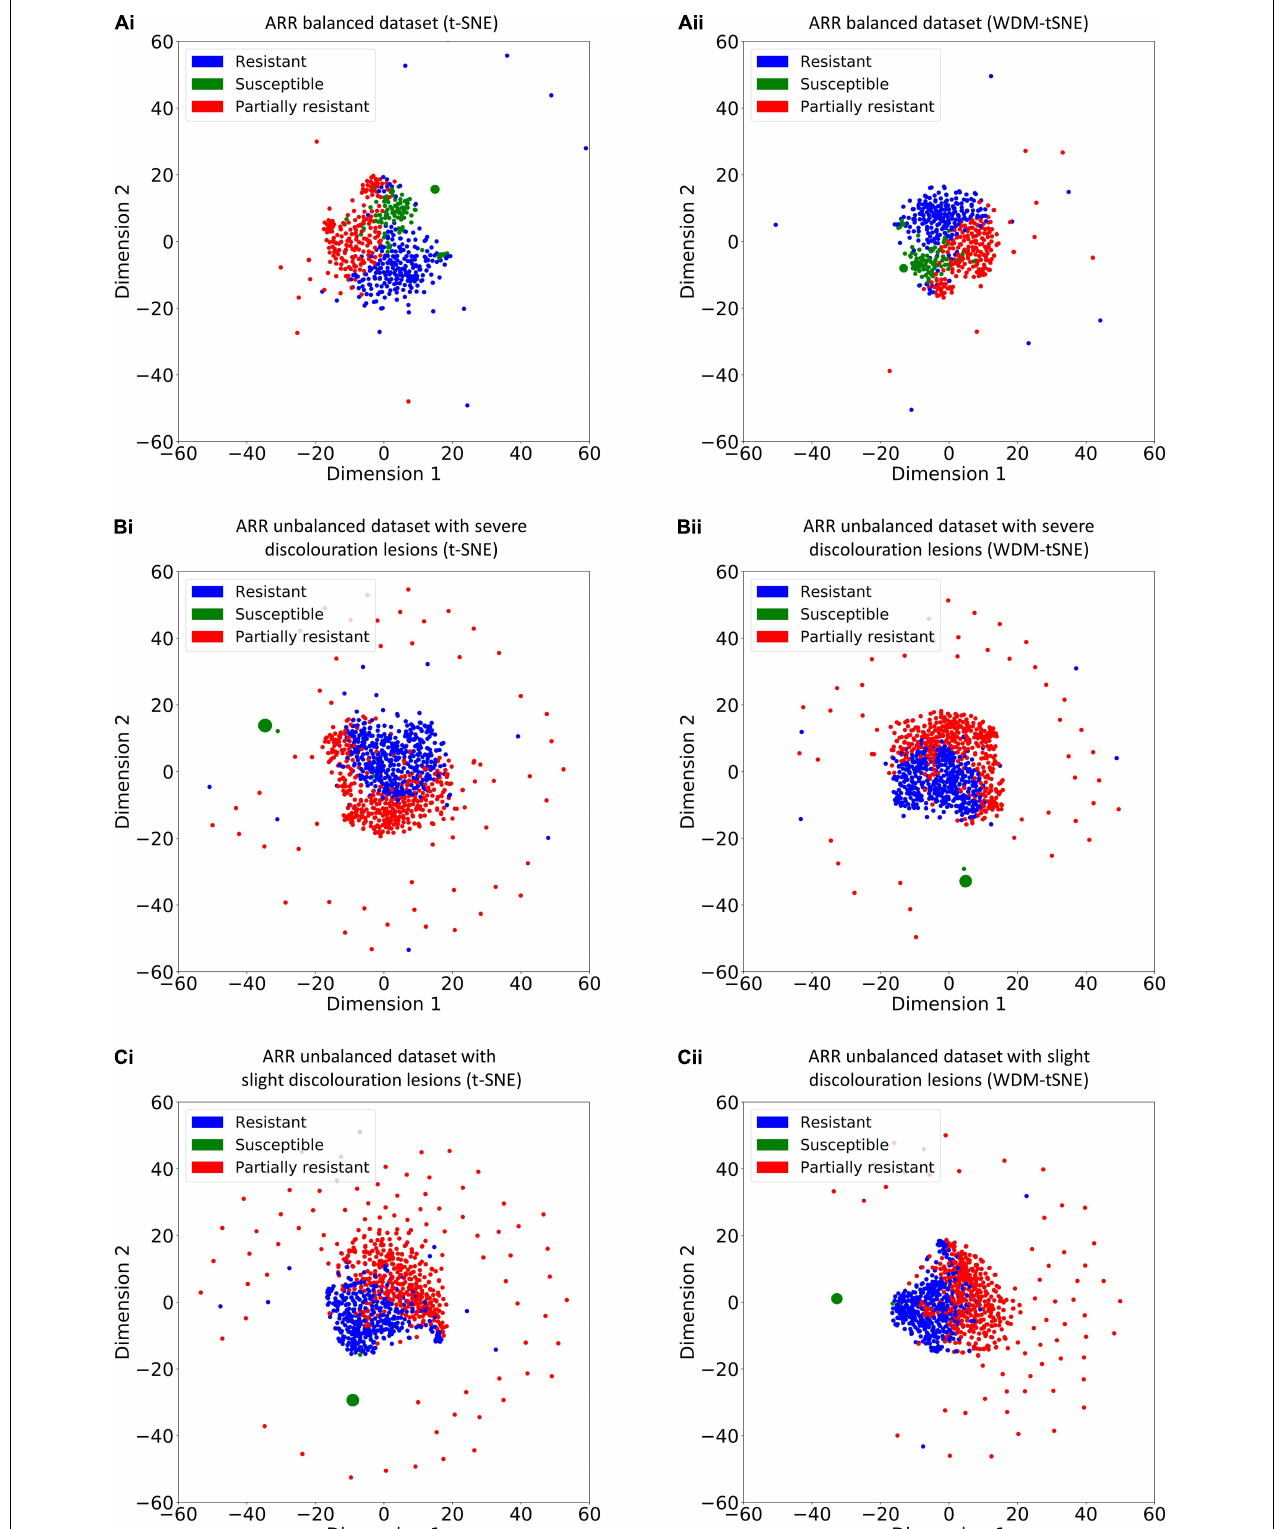
FIGURE 10 | The plots for the (A) balanced and (B–C) unbalanced datasets of ARR are based on (i) t-SNE and (ii) WDM-tSNE. WDM-tSNE, Aphanomyces Root Rot; Weighted Distance Metric and the t-stochastic neighbor embedding algorithm; ARR, Aphanomyces Root Rot.